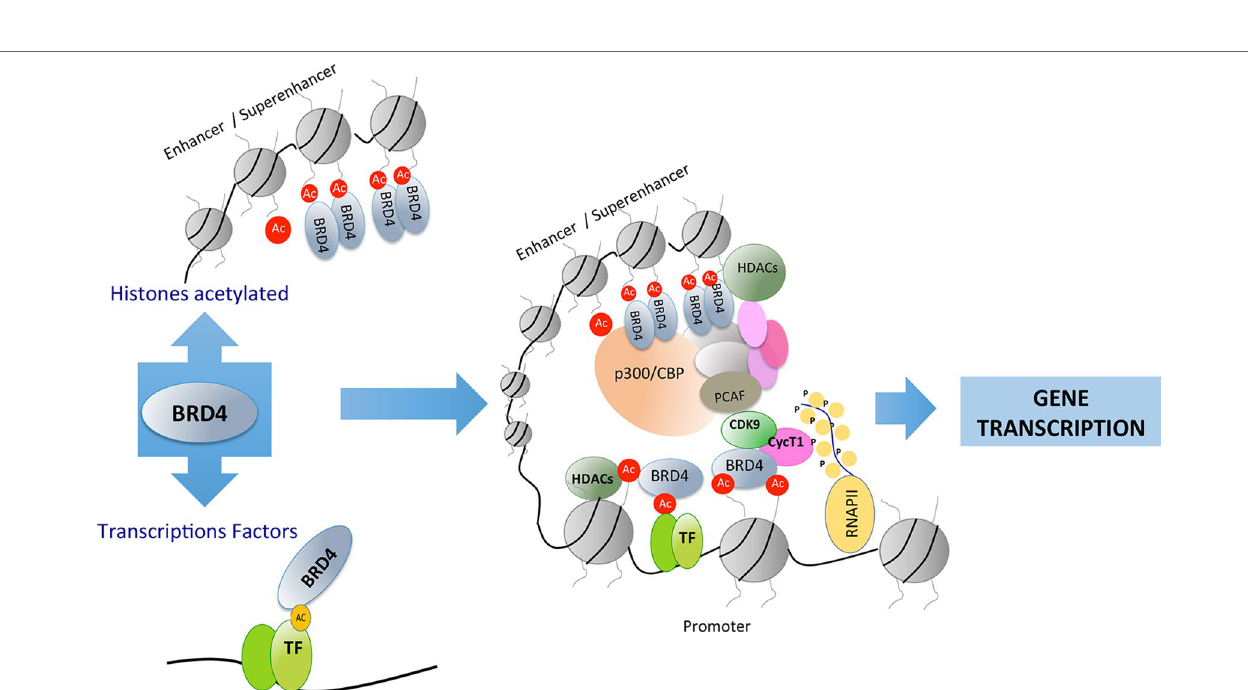
FIGURE 2 | Bromodomain and extraterminal (BET) proteins recognize acetylated residues in histones or in other proteins such as transcription factors. BET proteins can recruit transcription factors in distant areas from the promoter of genes involved in different cellular processes.